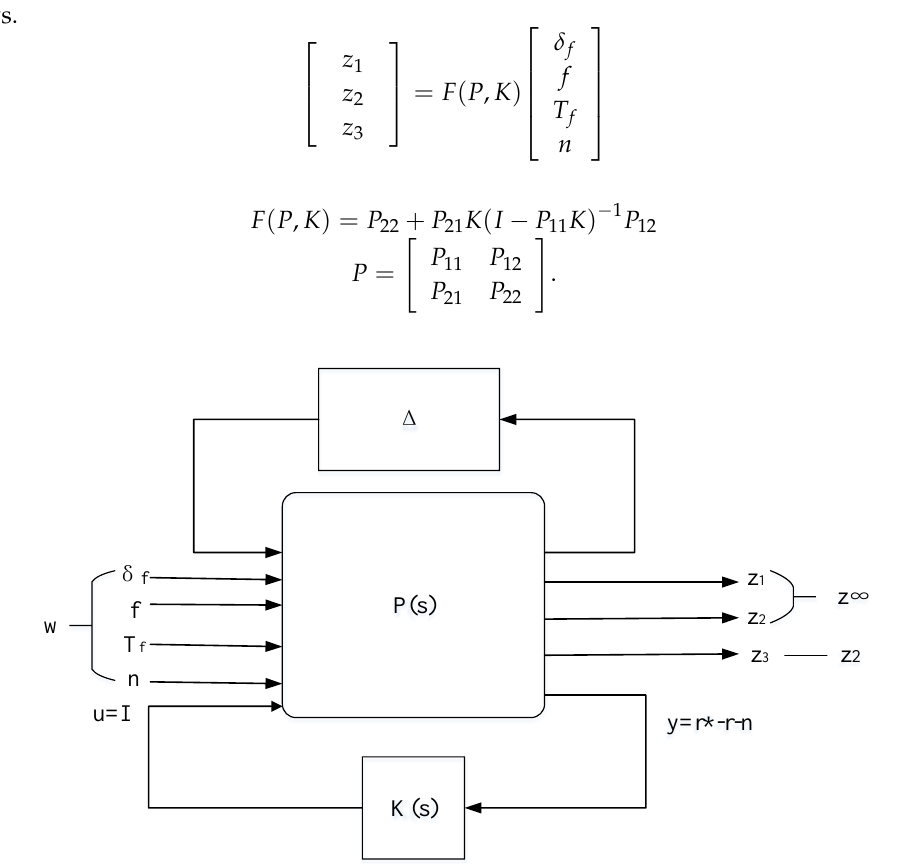
Figure 13. The stability control structure of the 4WS vehicle.